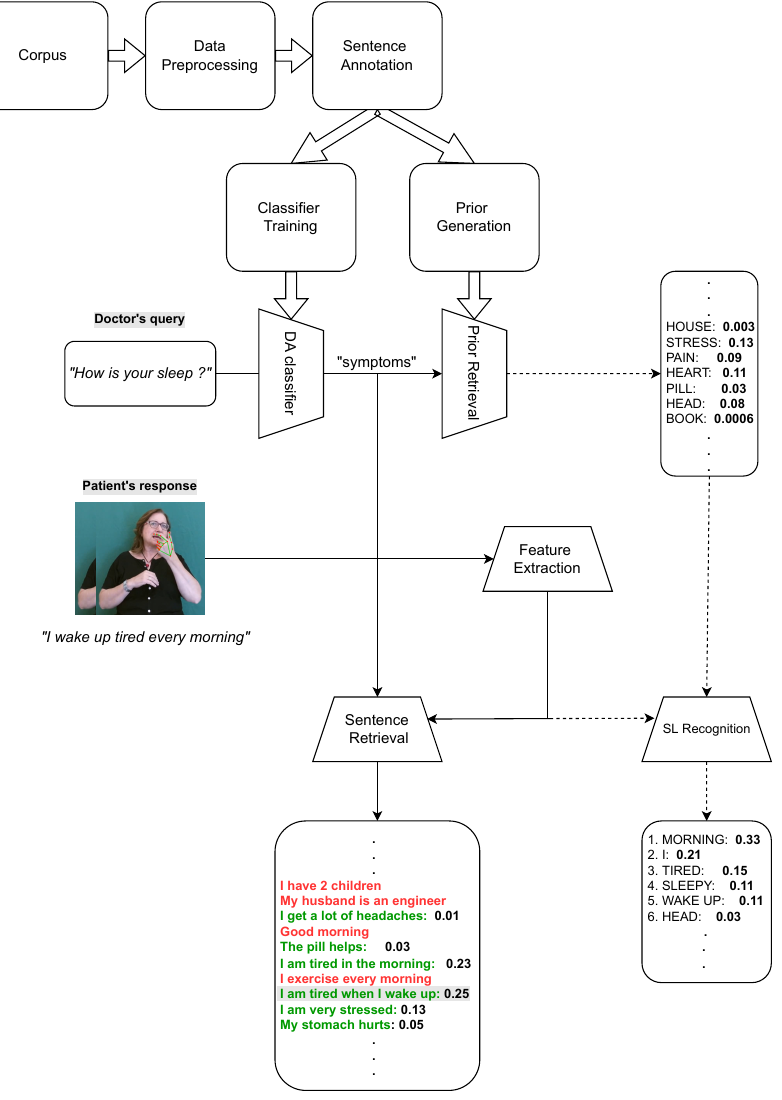
Figure 1. Architectural overview of the proposed framework. The dashed arrows represent the parts of the system that are currently under